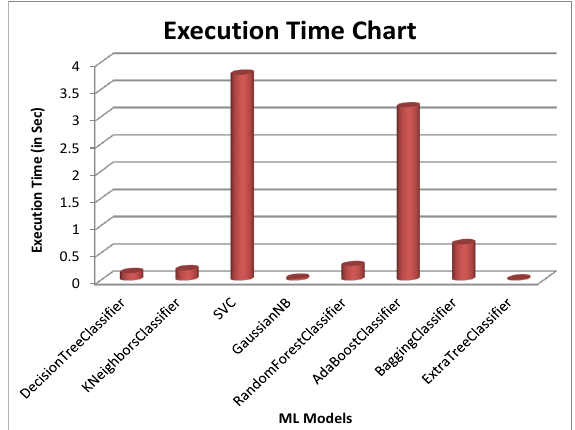
Figure 7. Accuracy Score Chart of ML Models